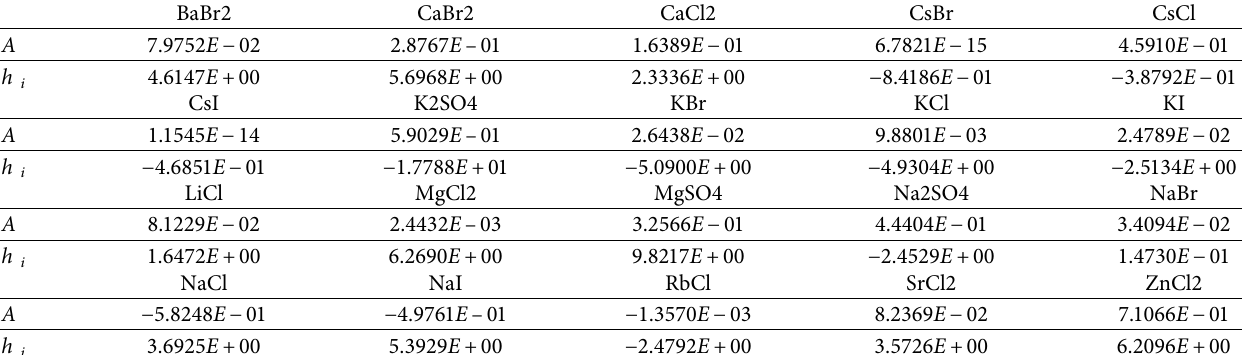
Table 6: The parameters α and